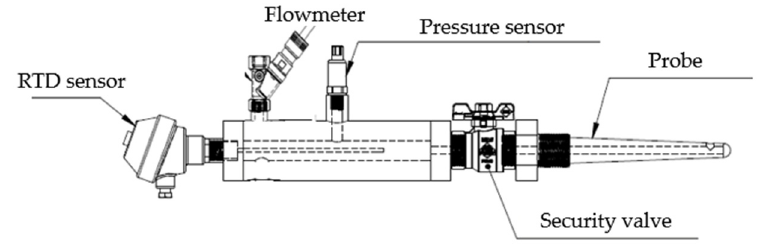
Figure 3. Manifold proposed and instrumentation.